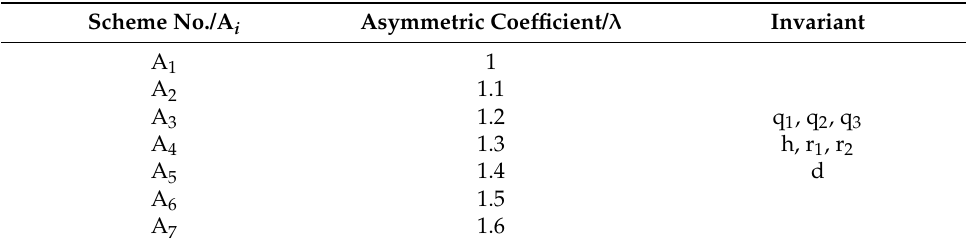
Table 1. Analysis scheme of different asymmetric coefficients.